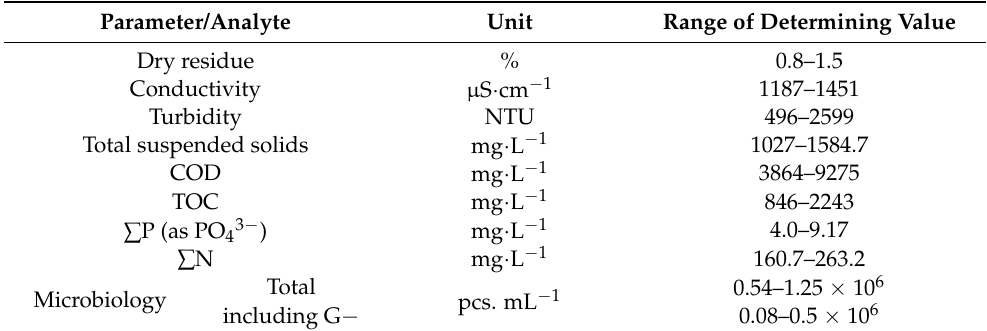
Table 1. Physicochemical parameters of the examined wastewater collected directly from the production